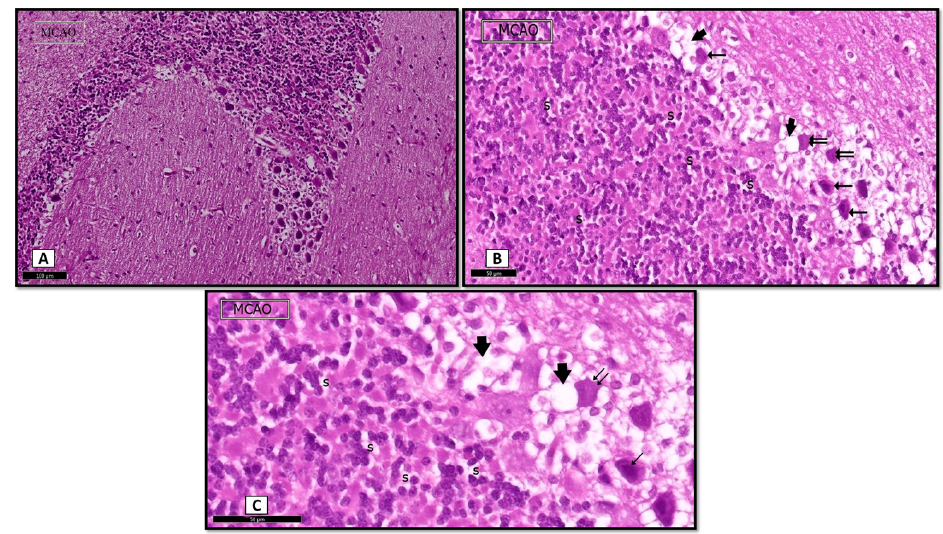
Figure 2. A section of MCAO rat showing: ( A ) the cerebellar cells of rats of the MCAO group shows destructive changes variable in severity and distribution. ( B ) Some Purkinje cells with homogenized cytoplasm and faint nuclei ( ↑↑ ). Notice vacuolation within the nearby molecular layer (Thick arrow). Granular layers show some spaces (s). ( C ) Higher magnification (H&E. A × 20, B × 40; Scale bar = 50 μ m).